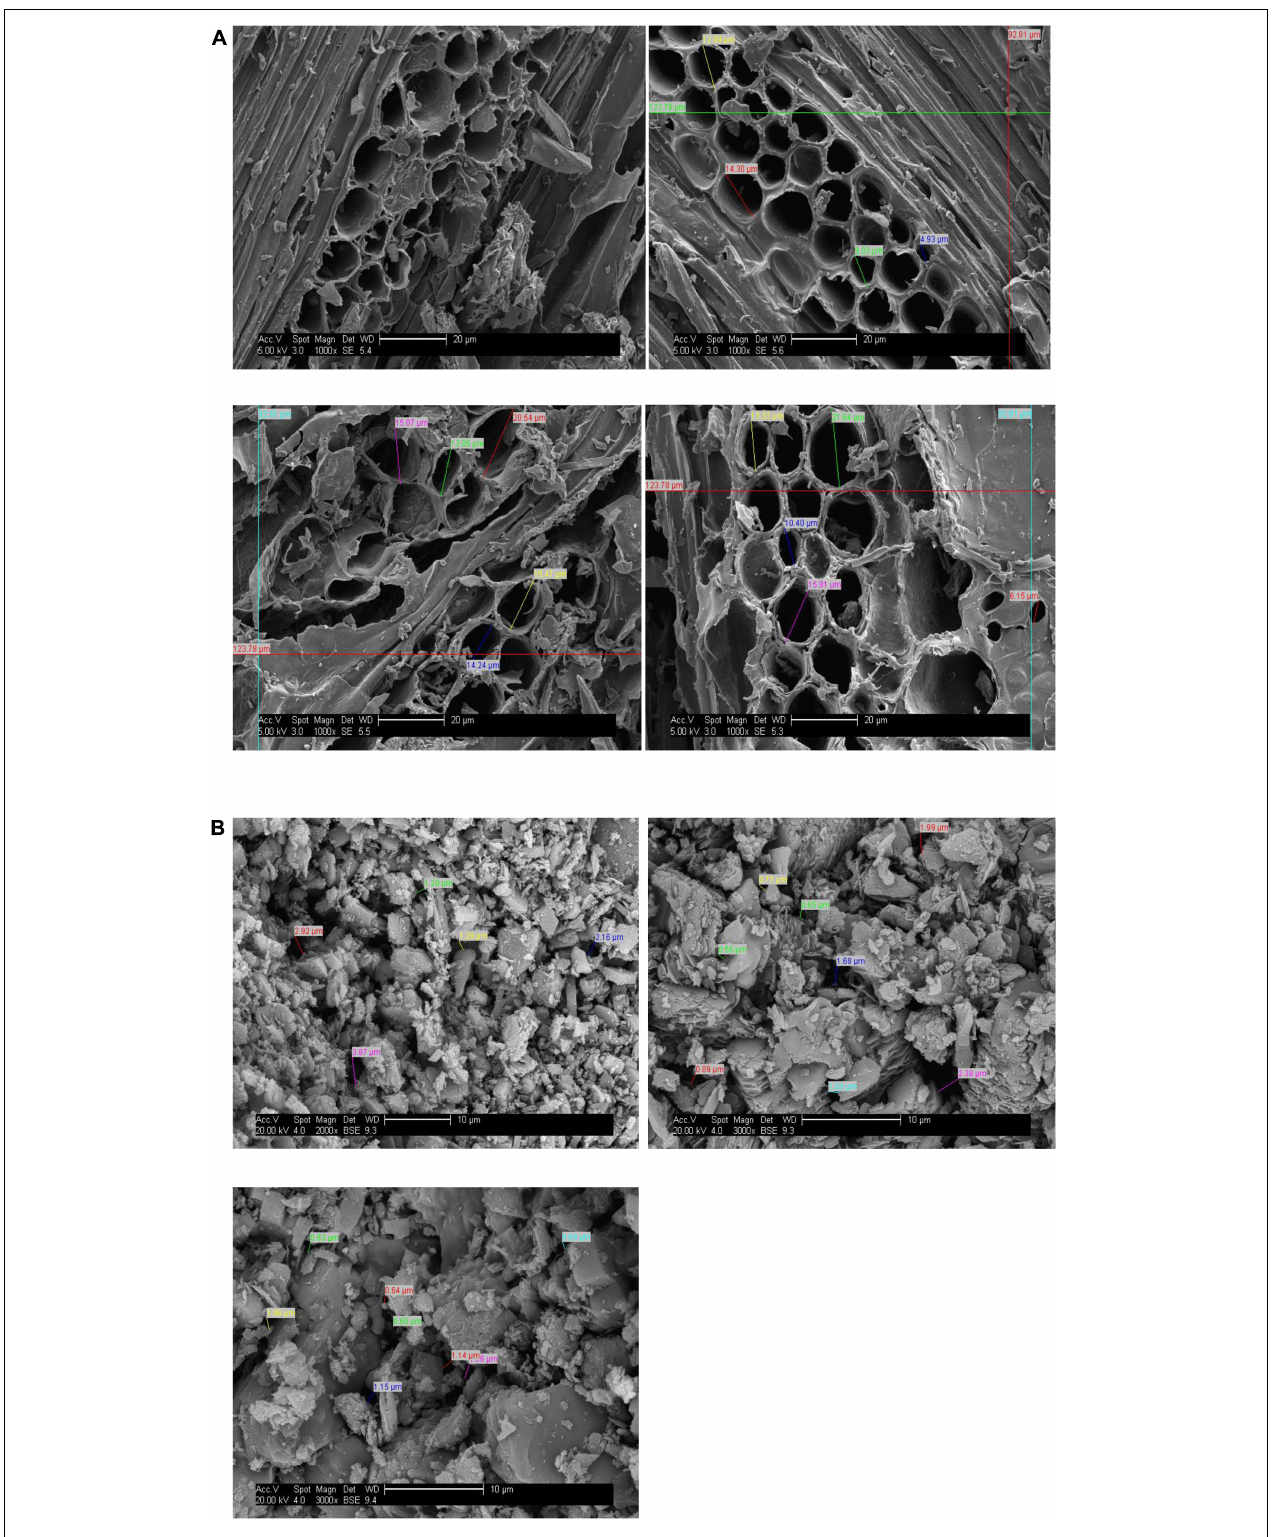
FIGURE 1 | Scanning electron microscope (SEM) photographs of panel (A) biochar produced from Dalbergia sissoo and (B) zeolite (clinoptilolite) showing their structure.